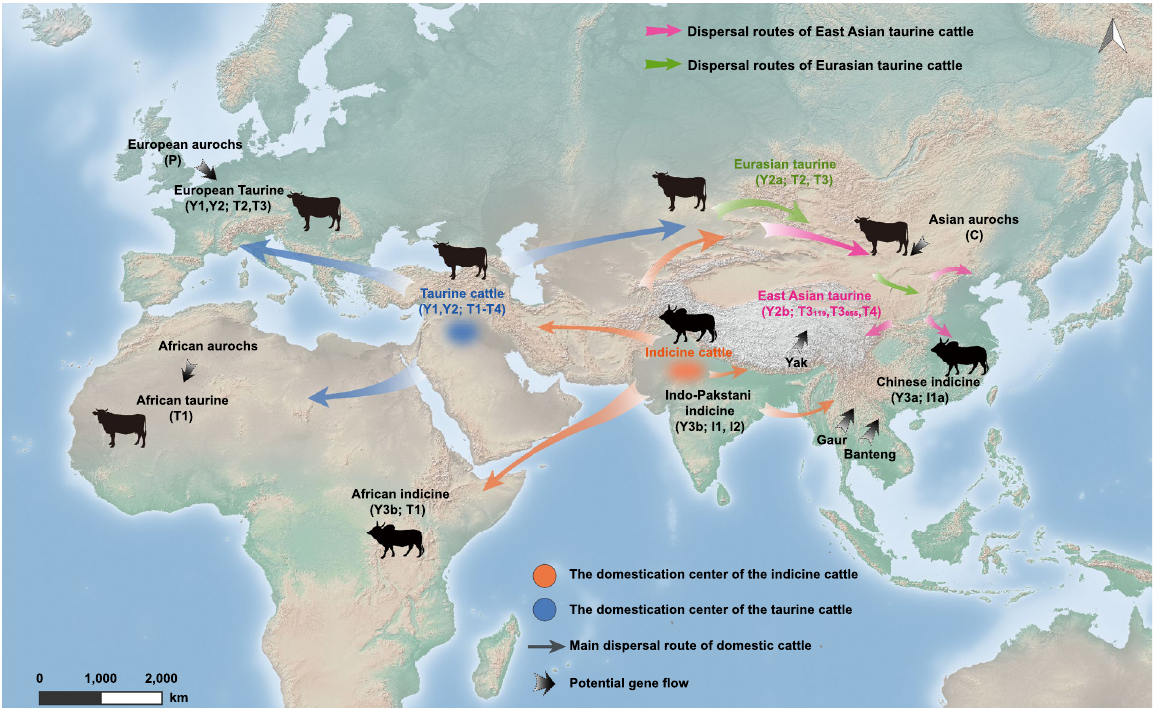
Fig. 1 Domestication and main migration routes of Bos taurus and Bos indicus . Paternal (Y) and maternal (taurine, T; indicine, I; and aurochs, P and C) haplogroups are shown in parentheses, separated by a